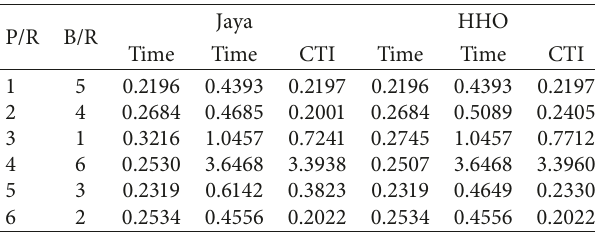
Figure 7: Independent runs for the 3-bus system by MINLP formulation. Table 7: Operating time and CTI for the 3-bus system by MINLP formulation.